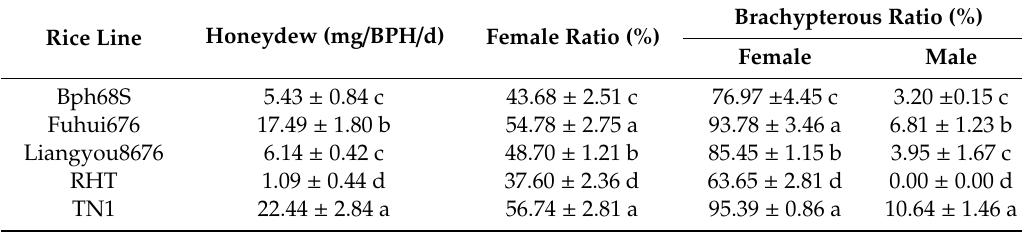
Table 2. Honeydew excretion, female ratio, and brachypterous ratio of BPH adults on di ff erent rice lines. Rice